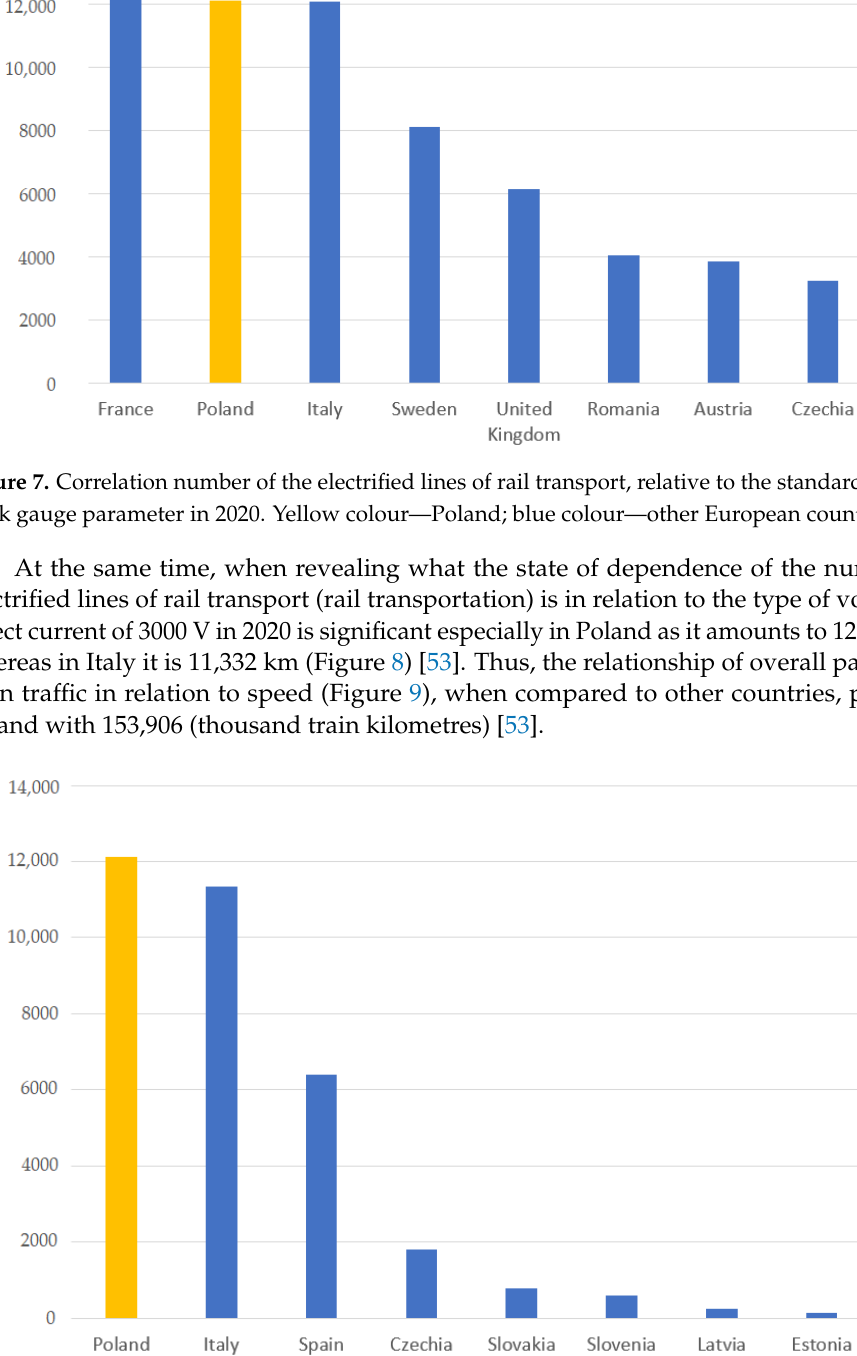
Figure 9. Correlation of the overall passenger train traffic versus speed in 2020. Yellow colour — Poland; blue colour — other European countries. 3.2. Case Study and Field Measurements 3.2.1. Characteristics of the Research Objects Measurement work was carried out on three real objects (object Nos. R 143 , R 144, R 161 ), which were represented by the three railways being studied in exploitation. This covered single- and double-track rail routes (railway tracks in open line), which are located in Po- land. The real objects were a total of five research objects, specifically railway tracks (object Nos. R 143_1_1 and R 143_1_2 , R 143_1_2 , R 144_1 , R 161_1 , R 161_2 ). These objects are characterised by dif- ferent geometric features in plan and profile, as well as operational elements of transport